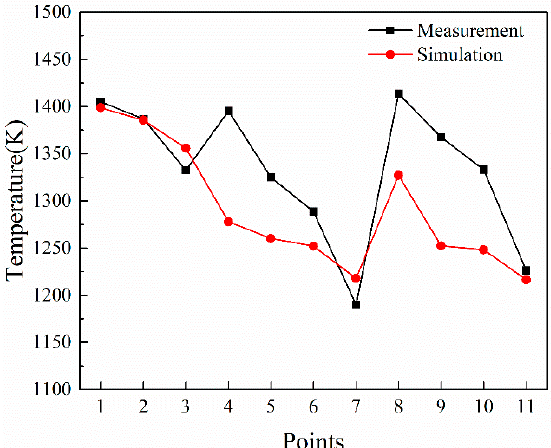
Figure 5. Measured and simulated temperatures.